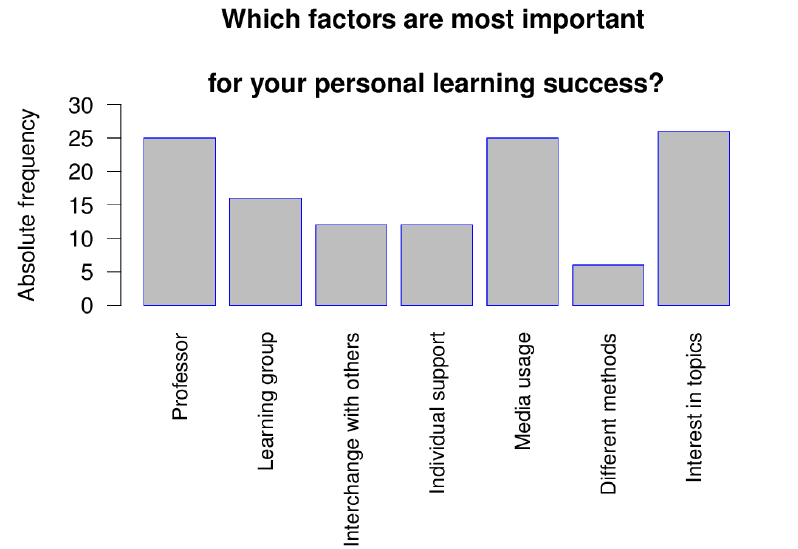
Fig. 7. Evaluation of the factors, which, according to the students, are most important for their personal learning